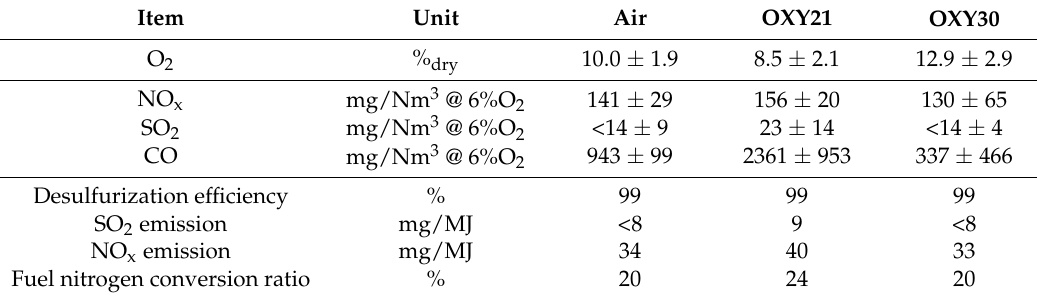
Table 4. Average emissions of oil shale firing in the CFB